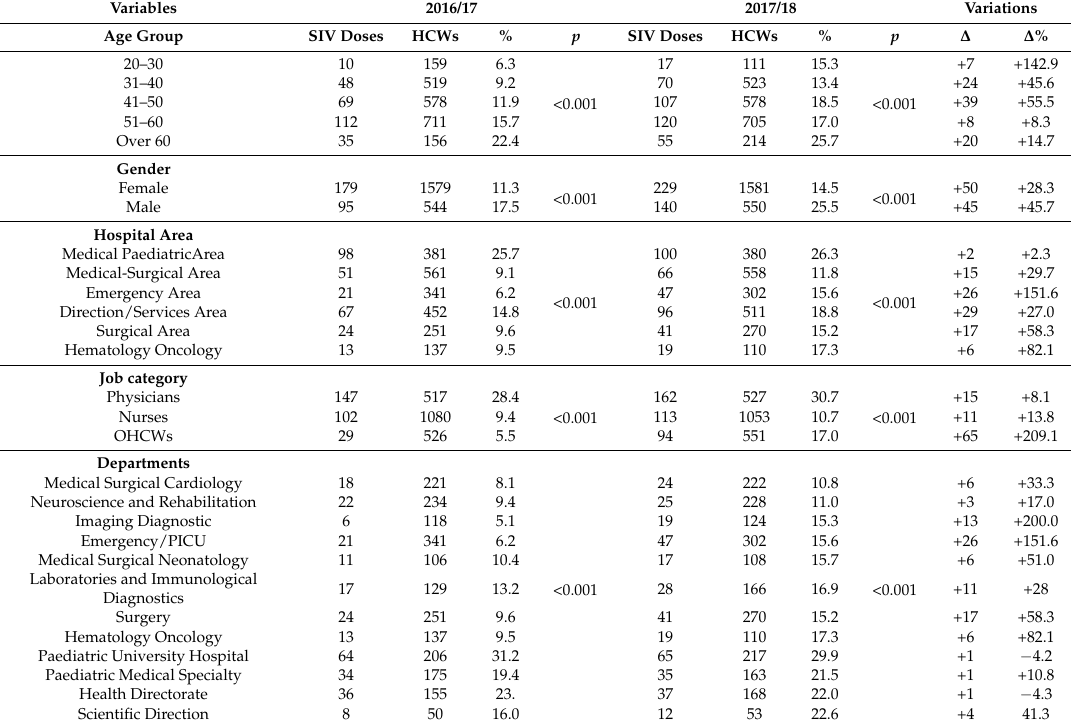
Table 1. SIV coverage rate per age group, gender, hospital area, job category and hospital